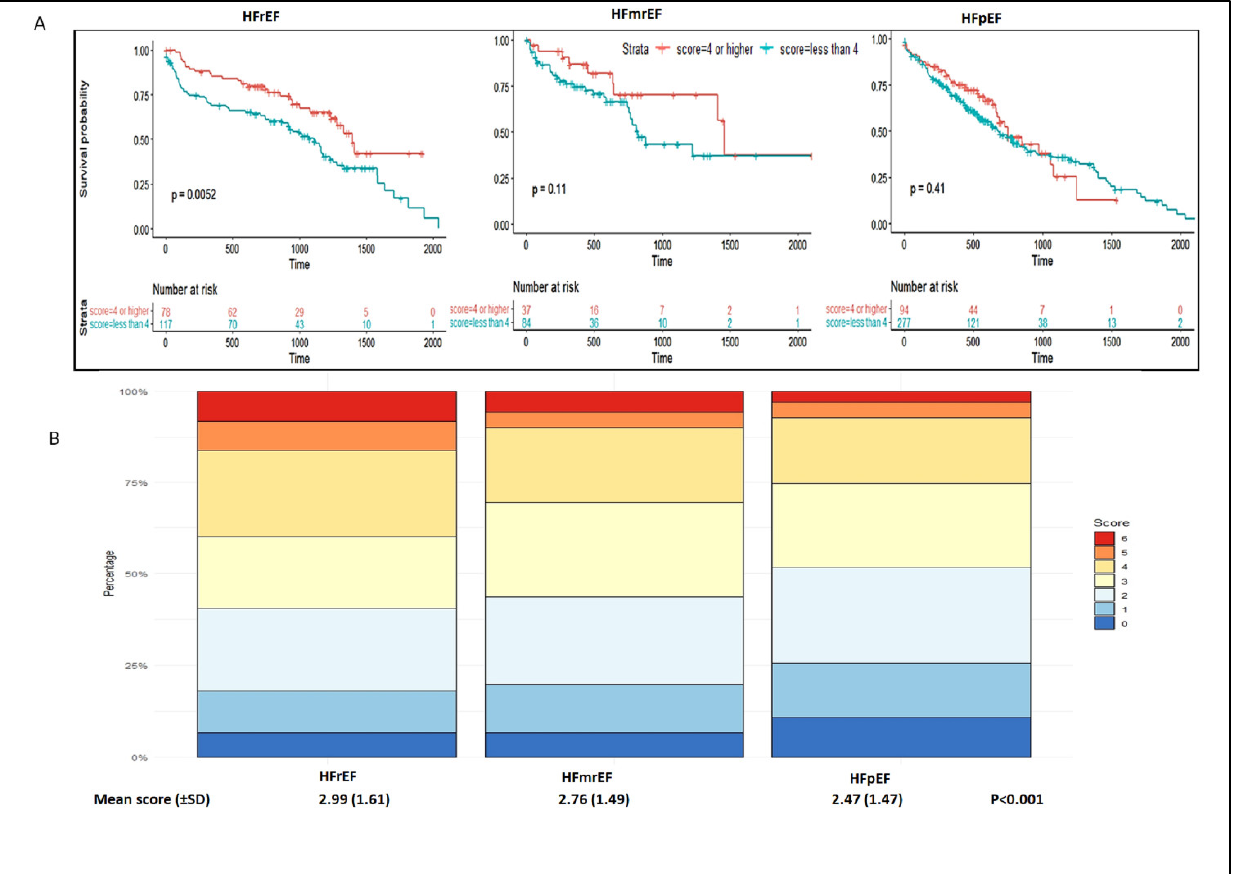
Figure 1. Survival plots according to the prescription score of HF drugs in HFrEF, HFmrEF, and HFpEF. ( A ) Survival plots; ( B ) prescription score for each phenotype. In panel B, the y-axis signifies the percentage of patients.